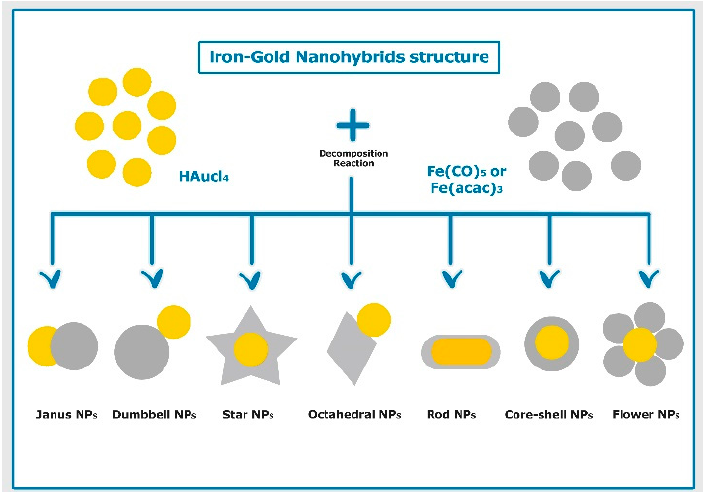
Figure 2. Schematic illustration of different structures of iron–gold hybrid nanoparticles prepared using thermal decomposition method.